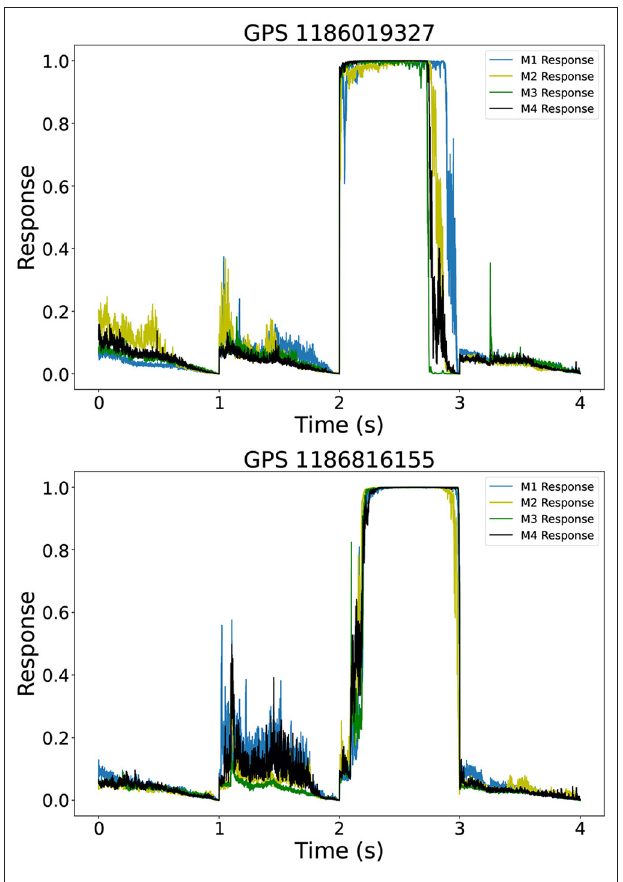
FIGURE 5 | Noise anomalies response of our AI ensemble to real glitches located at GPS times 1186019327 (top) and 1186816155 (bottom).